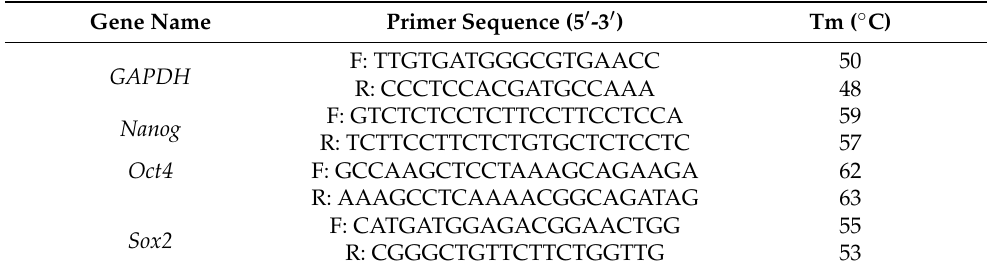
Table 1. The primer sequences used for